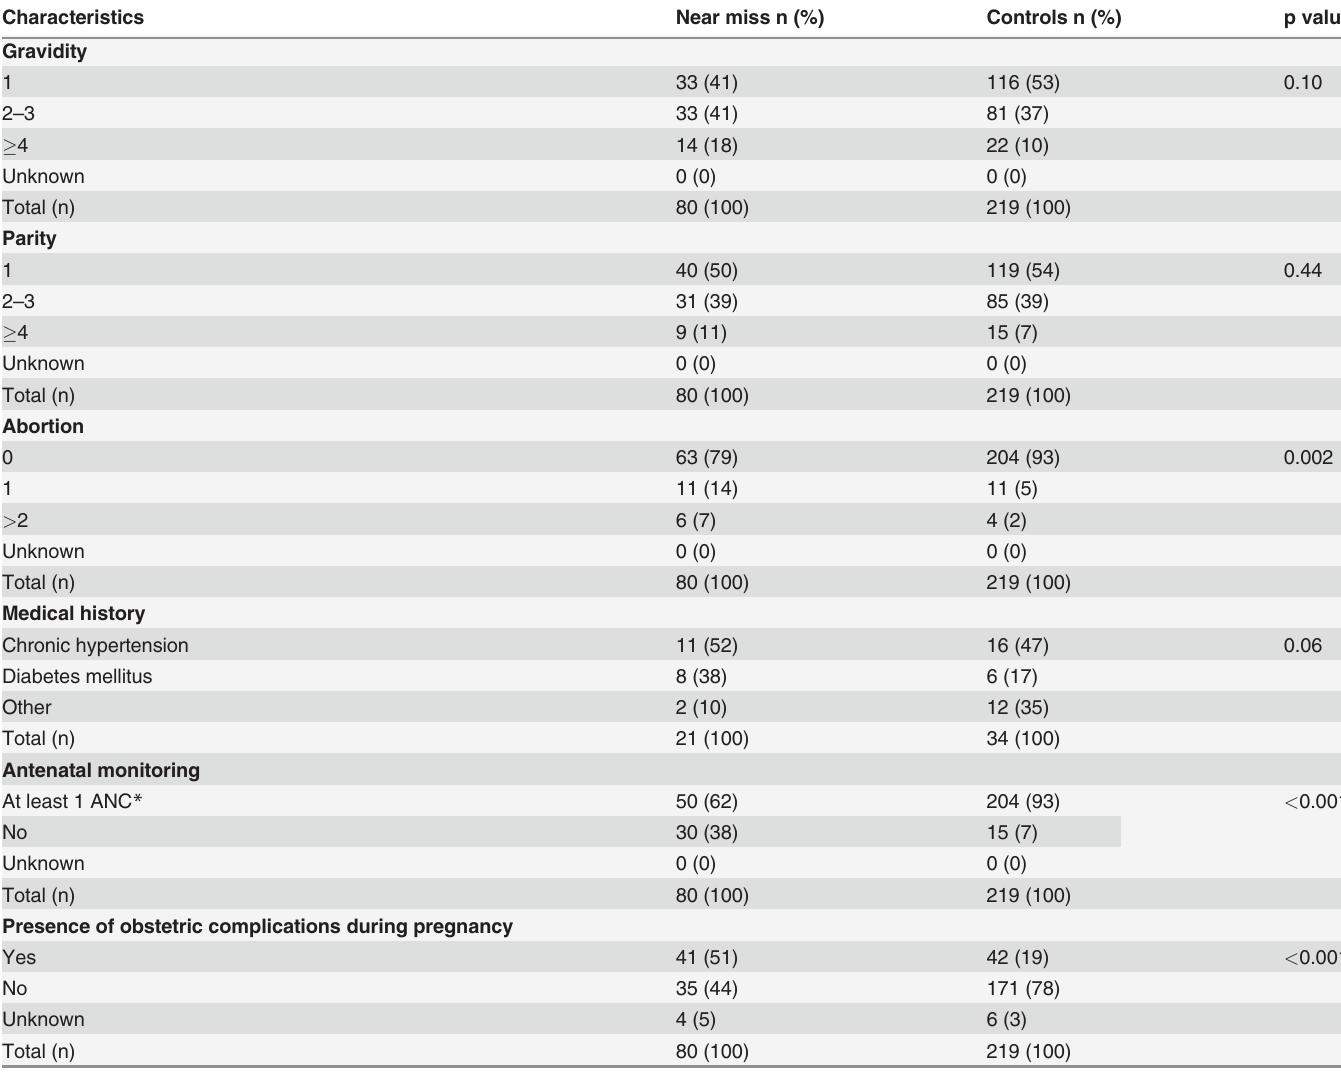
Table 2. Obstetric history and antenatal